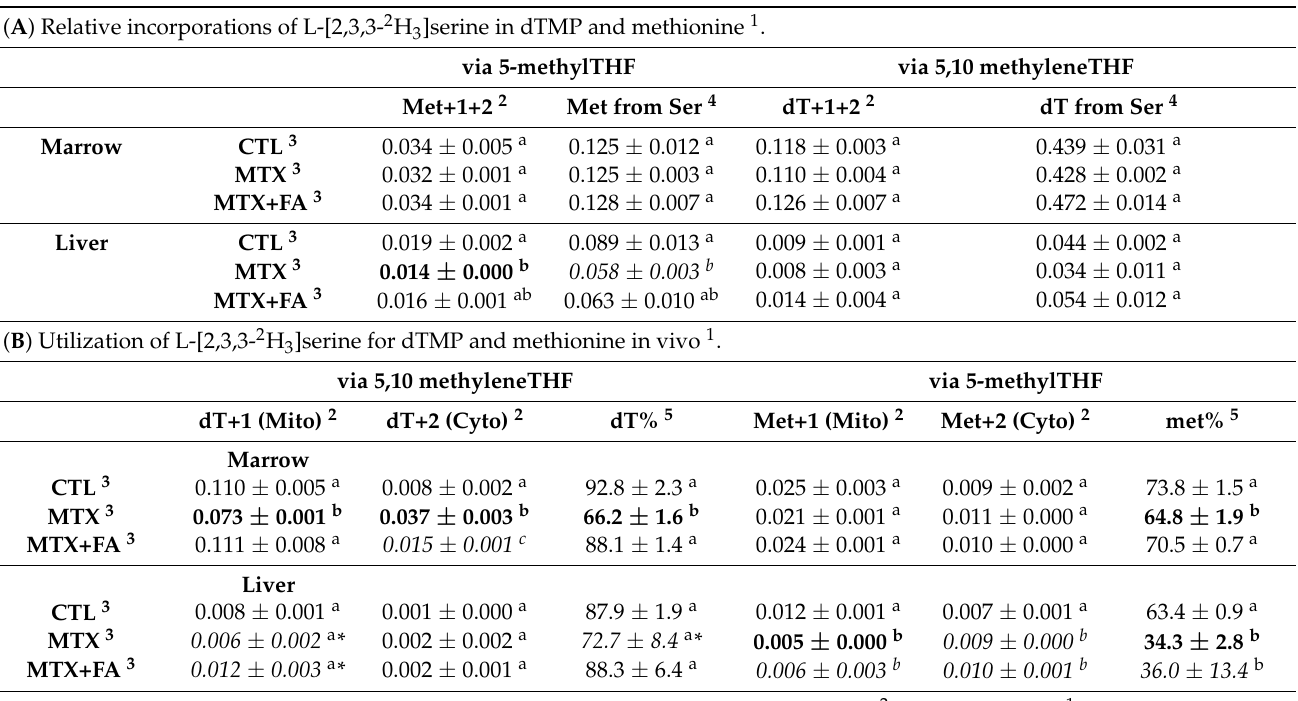
Table 4. MTX and folinate change the partitioning of methyleneTHF dependent 1C metabolic fluxes between mitochondrial and cytosolic derived formate in